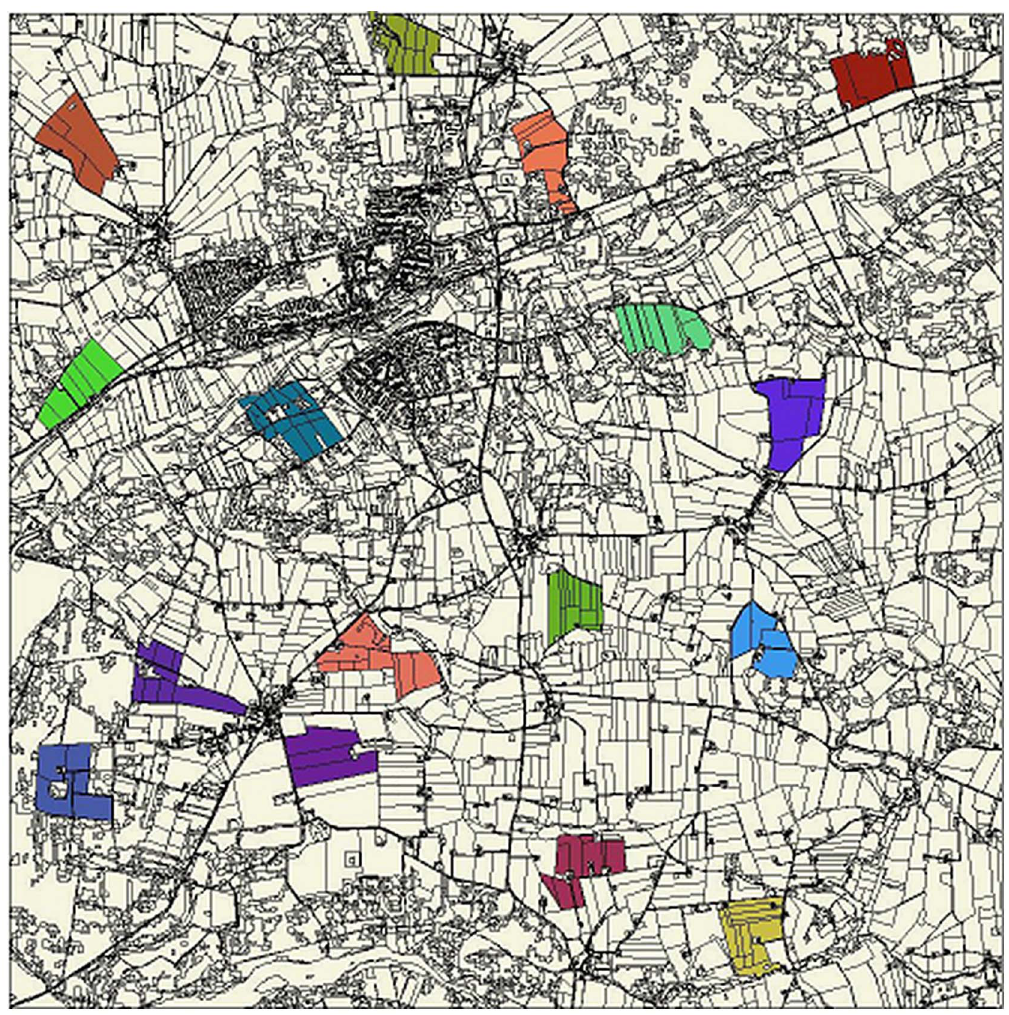
Figure 1. Map of the landscape around the town of Bjerringbro, showing the 16 study areas (shaded) in which data on skylark breeding densities were collected and virtual skylarks were sampled using